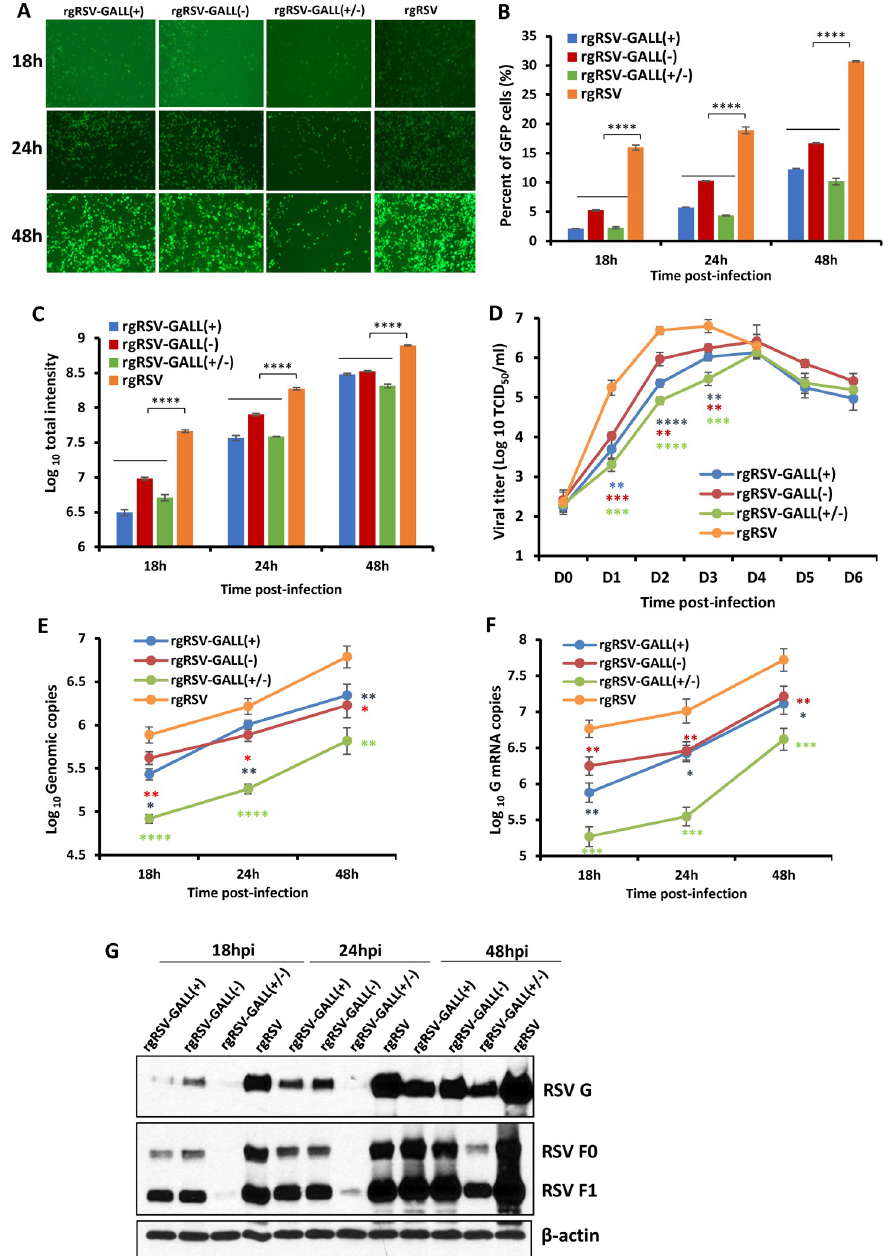
Fig 5. Replication of m 6 A-deficient RSVs is attenuated in A549 cells. (A) Delayed GFP expression by rgRSV mutants in A549 cells. Confluent A549 cells were infected by each rgRSV at an MOI of 0.1, and GFP expression was monitored at the indicated times by fluorescence microscopy. (B-C) Quantification of GFP positive cells by flow cytometry. Confluent A549 cells were infected by each rgRSV (MOI of 0.1). At the indicated time points, cells were trypsinized and GFP positive cells (B) and GFP intensity (C) were quantified by flow cytometry. (D) Single-step growth curve of rgRSV mutants. A549 cells in 24-well-plates were infected with each recombinant rgRSV at an MOI of 0.1. The viral titer was determined by TCID 50 assay in HEp-2 cells. (E) RSV genome RNA replication. At 18, 24, and 48 h post-infection, total RNA was purified from rgRSV-infected cells using TRizol, and genome RNA was quantified by real-time RT-PCR using specific primers annealing to the RSV leader sequence and GFP gene. (F) RSV G mRNA transcription. Viral mRNA was quantified by real-time PCR using primers annealing to the G. (G) Western blot analysis of RSV F and G protein expression. A549 cells were infected with the parental rgRSV or rgRSV mutants at an MOI of 0.1. At 18, 24, and 48 h post-inoculation, total cell lysates were harvested and subjected to Western blotting using a monoclonal antibody against RSV F or G protein. The RNA copy and viral titers are the geometric mean titer